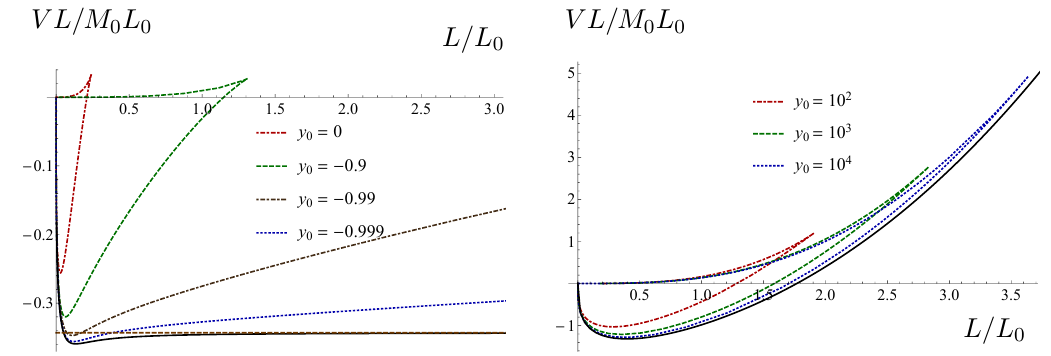
solutions and for the B 1 solution, 8 8 solutions with Q k scaled as Q 2 = (cid:26) 2 = 2 y 0 , 0 8 k solution, whose quark-antiquark potential is 8